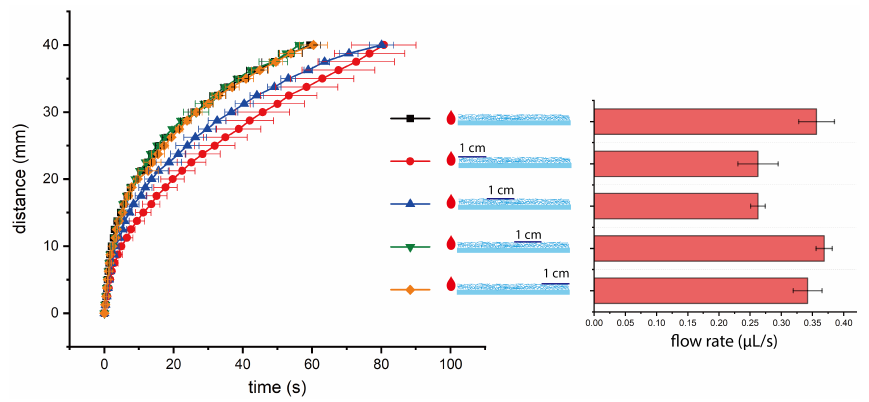
Figure 5. The time-distance plot of DI water flow on nitrocellulose test strips with tapes of same length but on different positions ( left ), and the average flow rates of different groups ( right